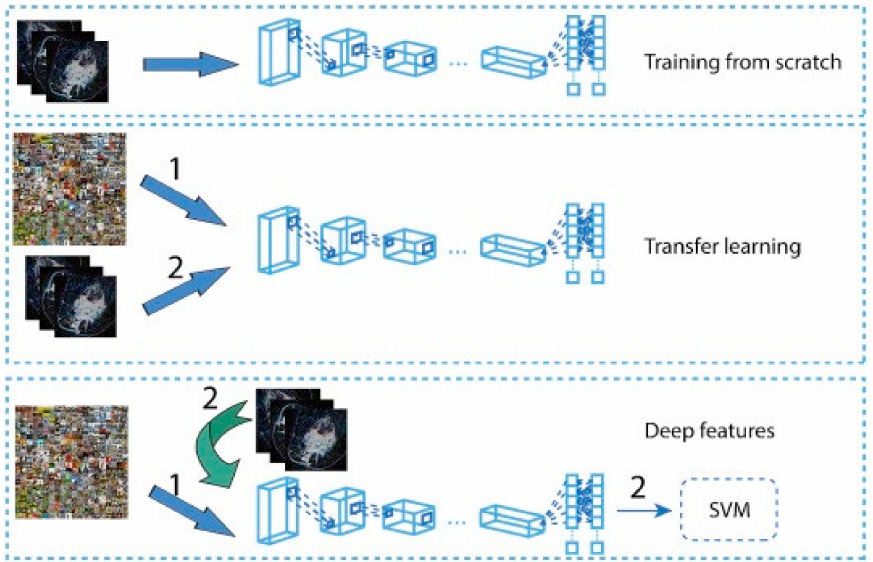
Figure 9. A model architecture for cancer subtypes prediction via ResNet 50 and CNN models from